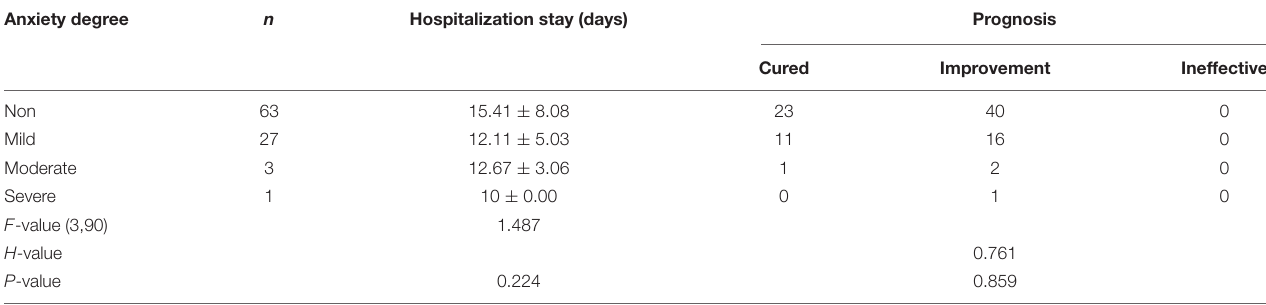
TABLE 5 | Effect of anxiety on the recovery of